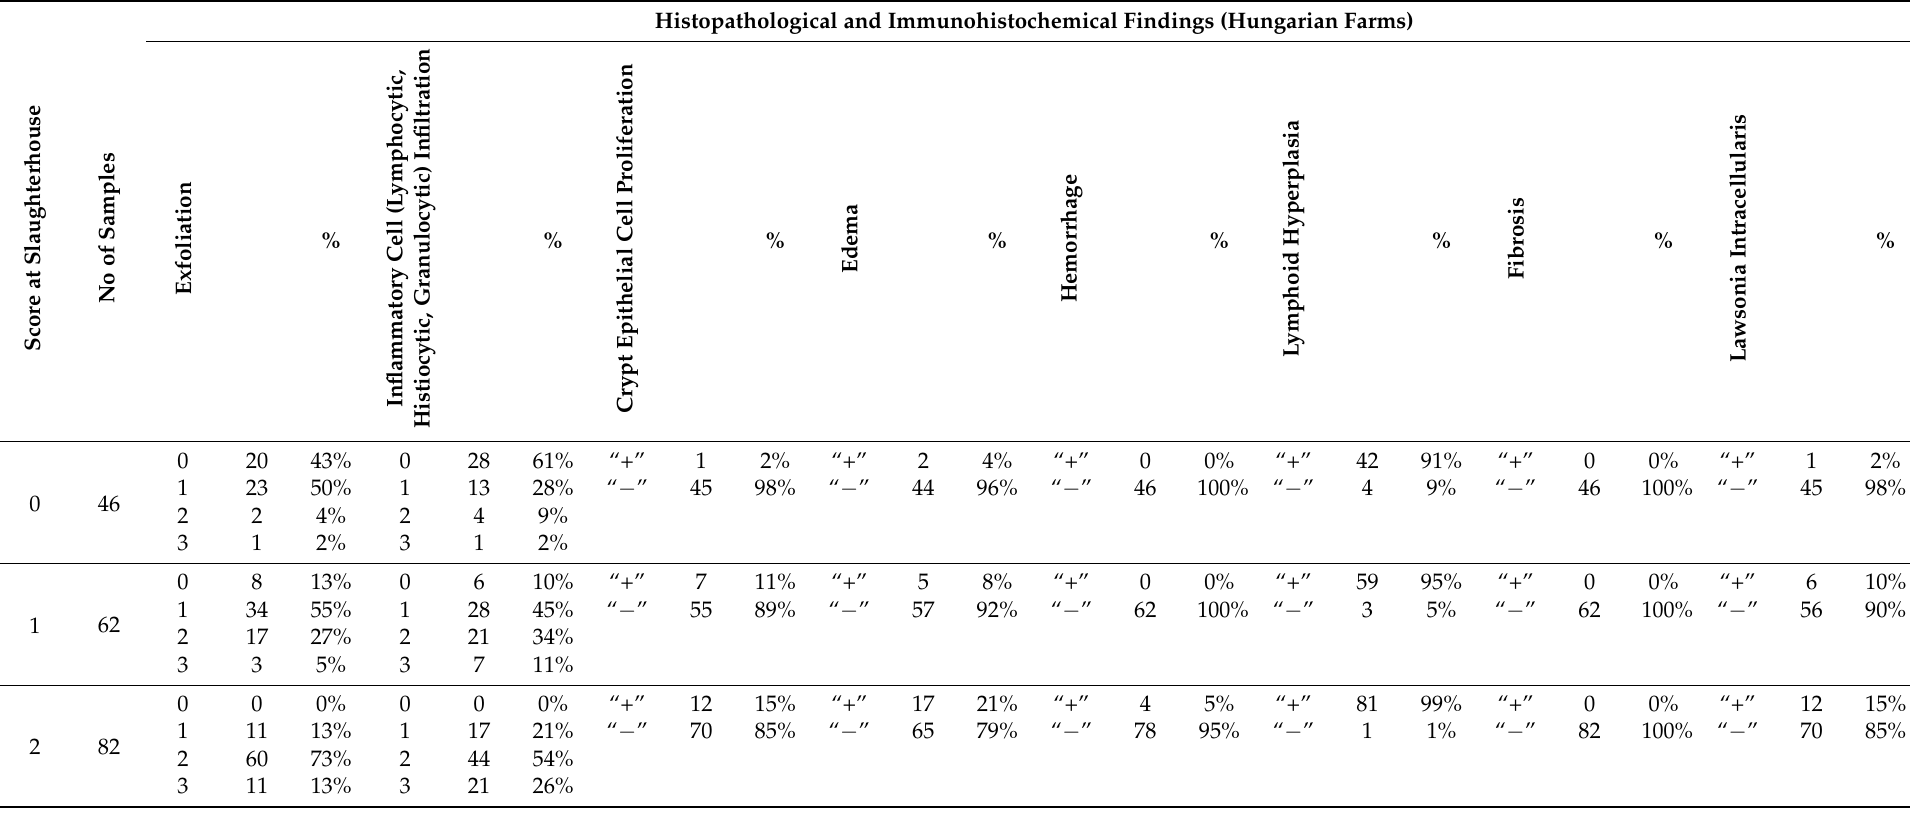
Table 4. VP versus Histopathology and